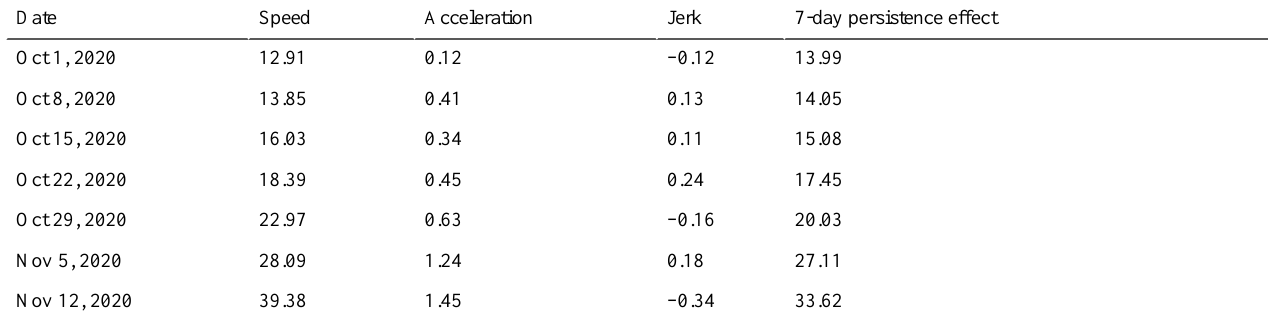
Table 4. US pandemic